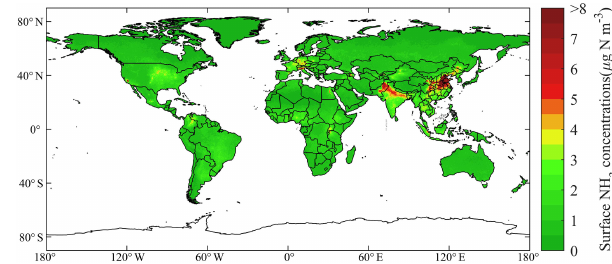
Figure 9. Spatially satellite-based surface NH 3 estimates in 2014 (Liu et al., 2019). The global surface NH 3 concentration datasets have been released on the website: https://zenodo.org/record/ 3546517#.Xj6I4GgzY2w, last access: 17 July